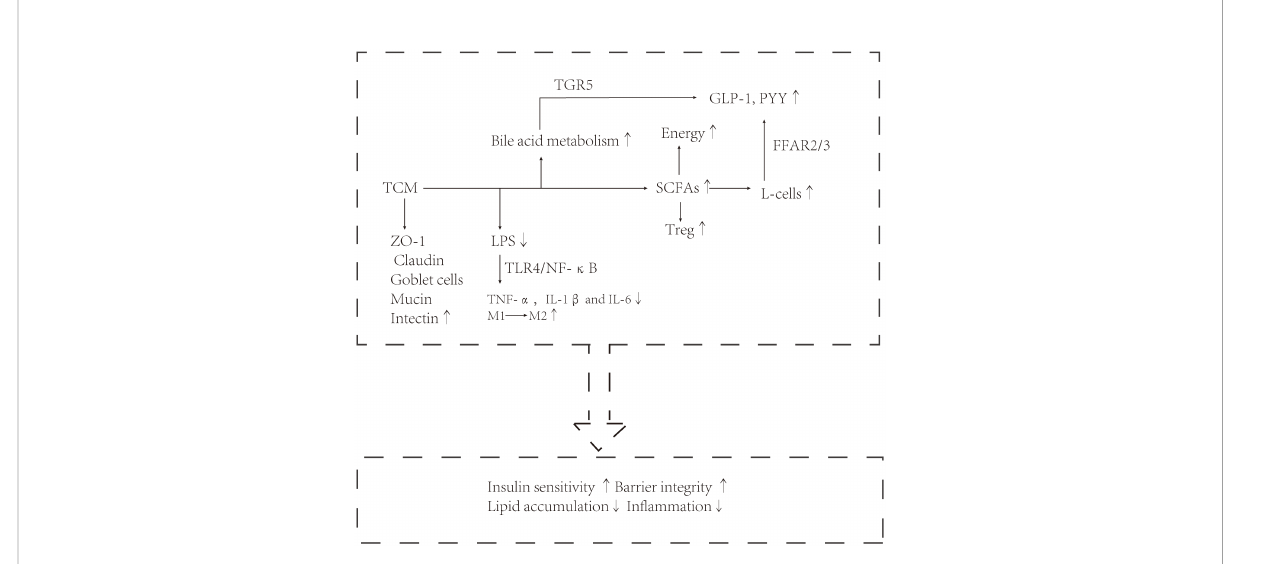
FIGURE 2 Traditional Chinese medicine exerts a therapeutic effect through intestinal fl ora, such as enterococcus, Akkermansia, and Vibrio